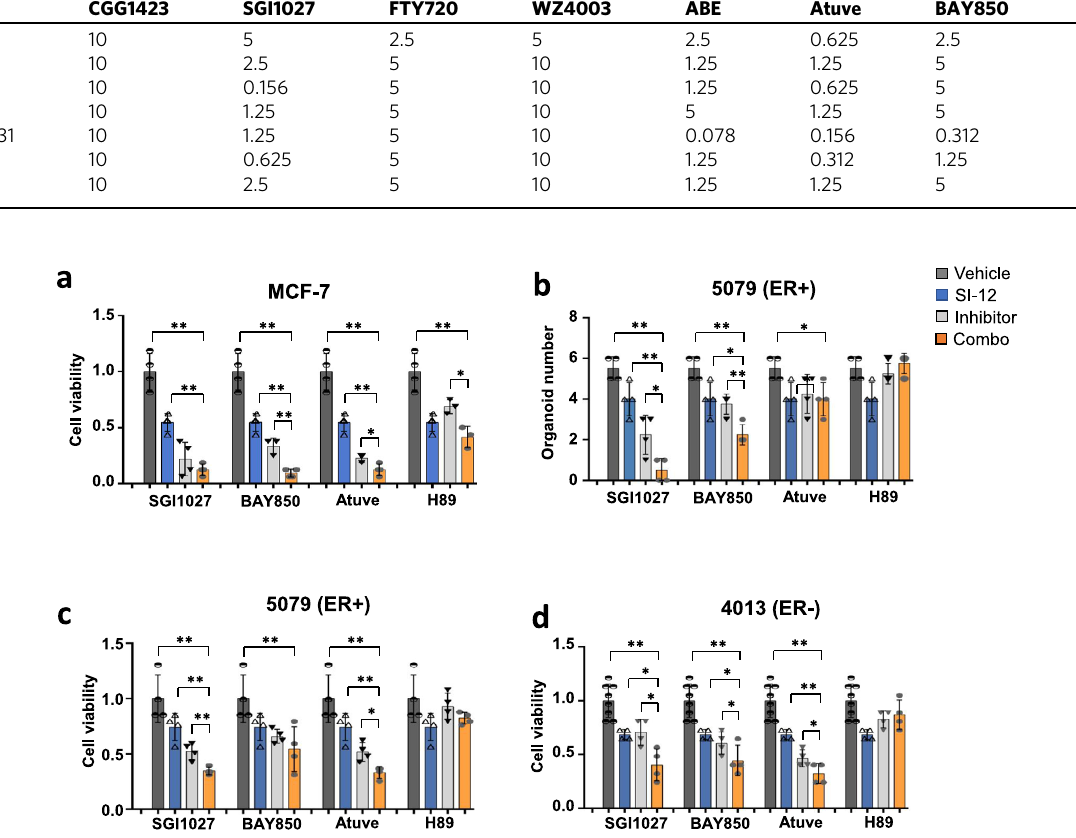
Fig. 7 Drug combination experiments in cancer organoid models. a Cell viability in MCF-7 cells-derived organoids. b The number of PDX 5079 organoids in each well was counted after 2 weeks of treatment. c Cell viability in ER + PDX 5079 organoids. d Cell viability in TNBC PDX 4013 organoids. All the experiments were performed for 2 weeks after which the organoid and cell number were counted. Fresh medium with or without drugs was provided every 3 – 4 days. ** P < 0.01, * P < 0.05 two-tailed Student ’ s t